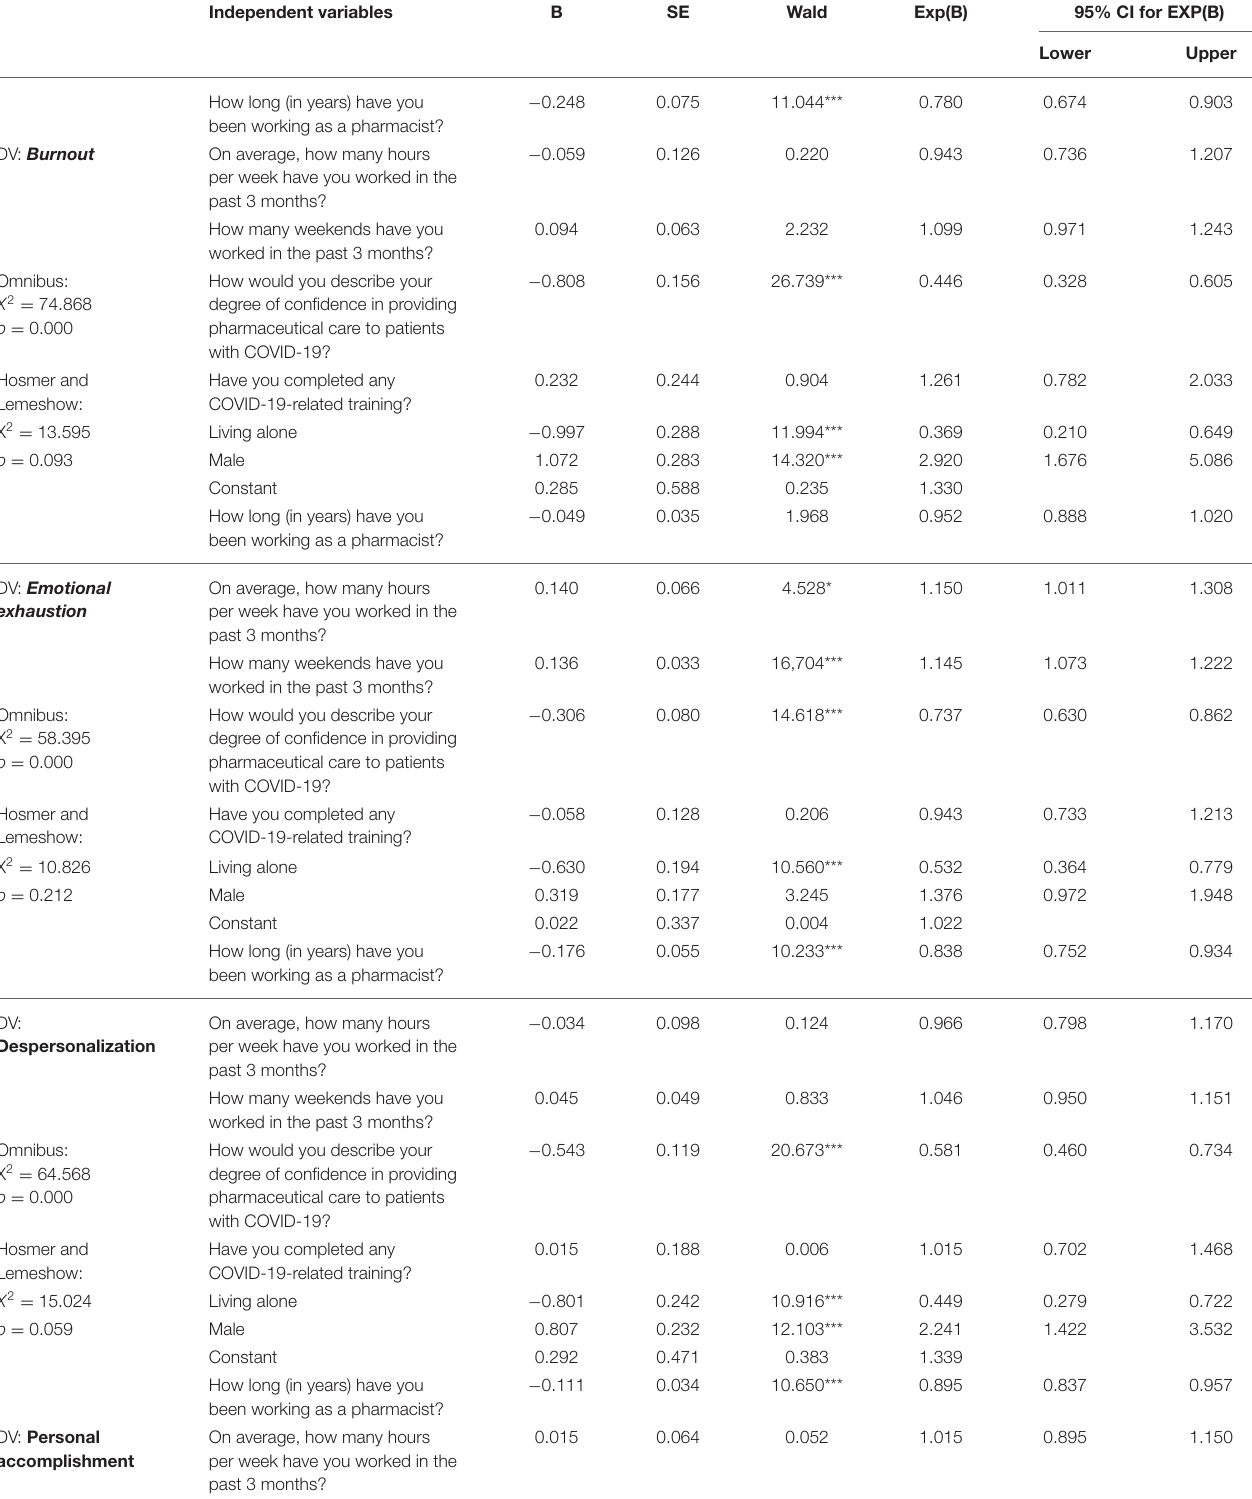
TABLE 4 | Variables with predictive power over MBI-HSS scores (Logistic regression). Independent